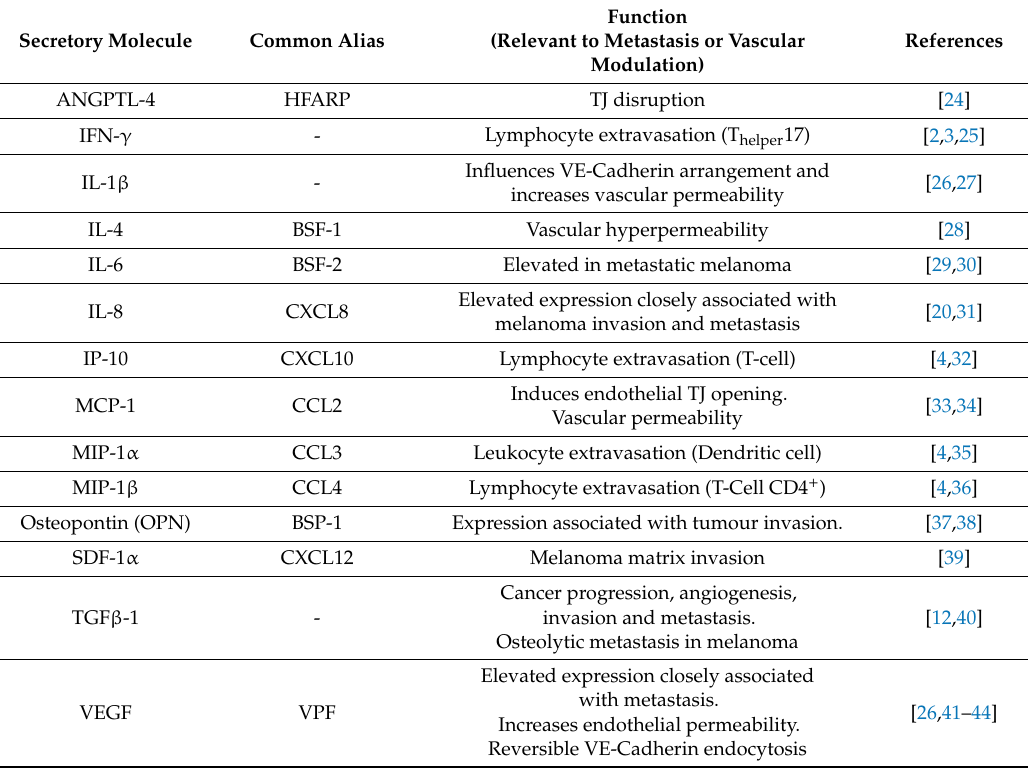
Selected secreted molecules quantified in the melanoma secretome using CBA or Luminex assays. Secretory Molecule Common Alias